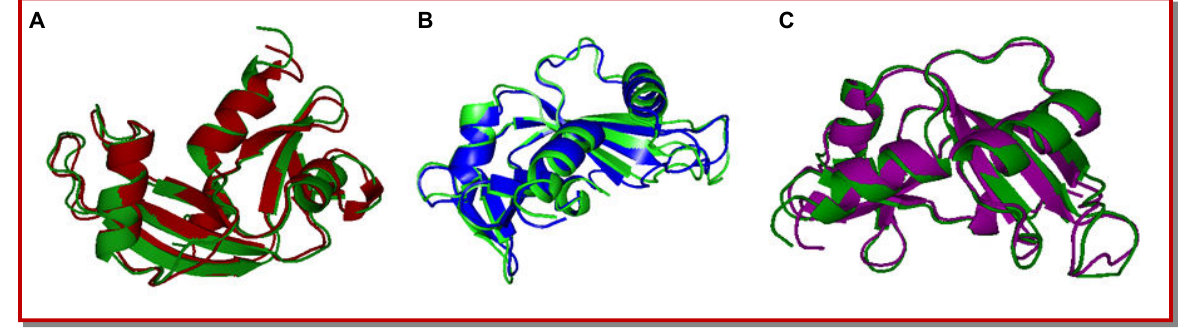
Figure 2: Superimposed structure of the native protein (green) with mutant (A) Superimposed structure of native angiogenin (green) with mutant Q36L (red) structure showing RMSD of 1.27 Ǻ. (B) Superimp osed structure of native angiogenin (green) with mutant C63W (blue) structure showing RMSD of 1.37 Ǻ. (C) Superimposed structure of native angi ogenin (green) with mutant H138R (magenta) structure showing RMSD of 1.20 Ǻ.